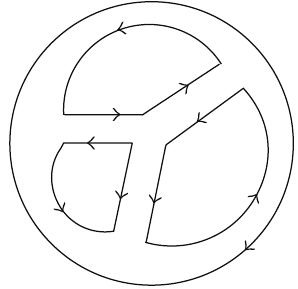
Figure 2: This diagram consists of 4 three-point vertices, 6 propagators, and 4 index loops.